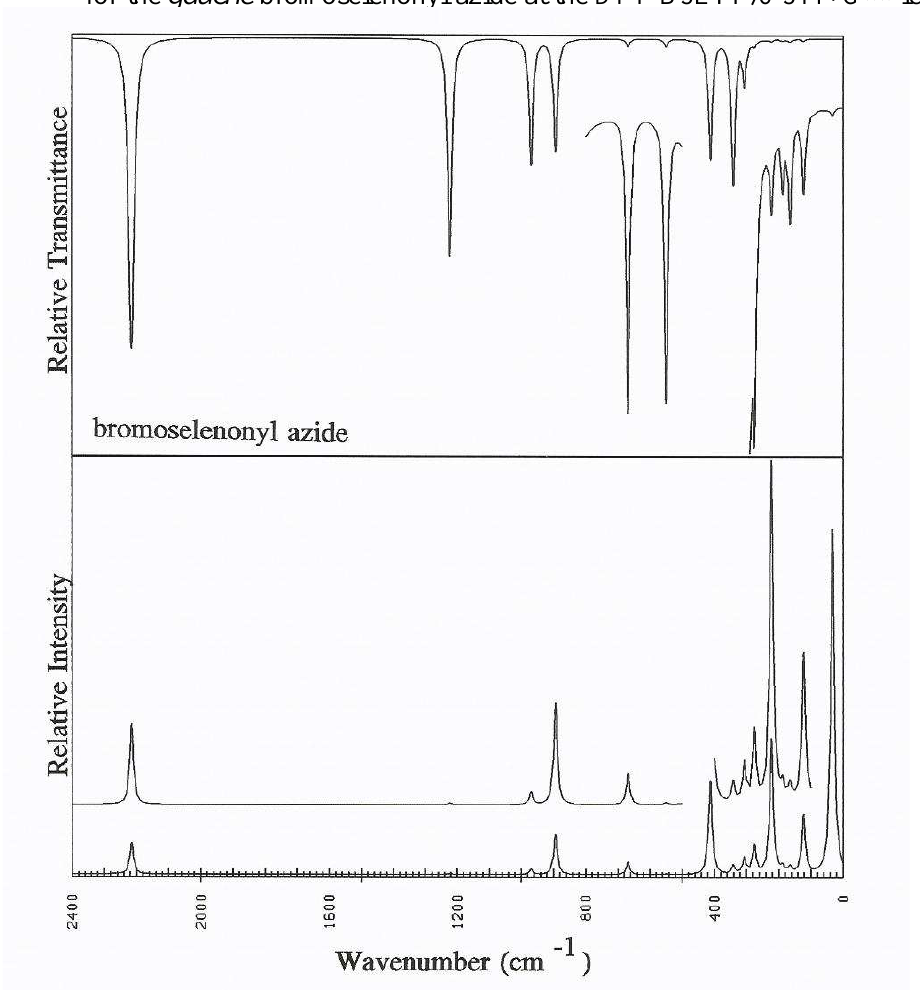
Figure 5 : Calculated vibrational infrared (upper panel) and Raman (lower panel) spectra for the gauche bromoselenonyl azide at the DFT-B3LYP/6-311+G**